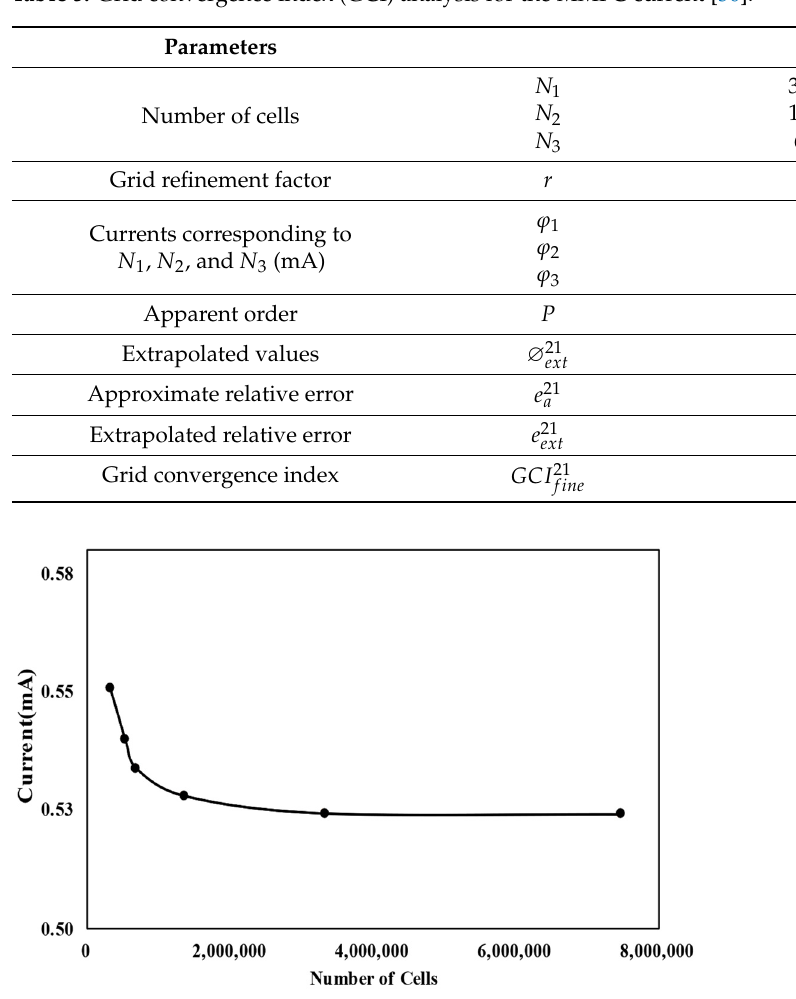
Figure 4. Grid-dependency test for MMFC current [30].